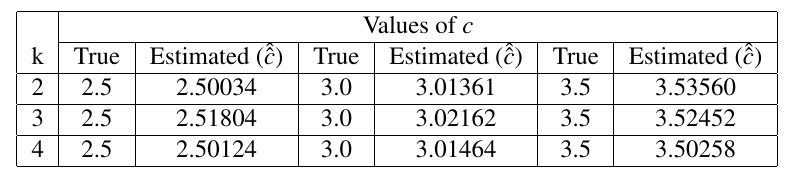
Estimates of c for various values of k based on GURV’s of a simulation study with